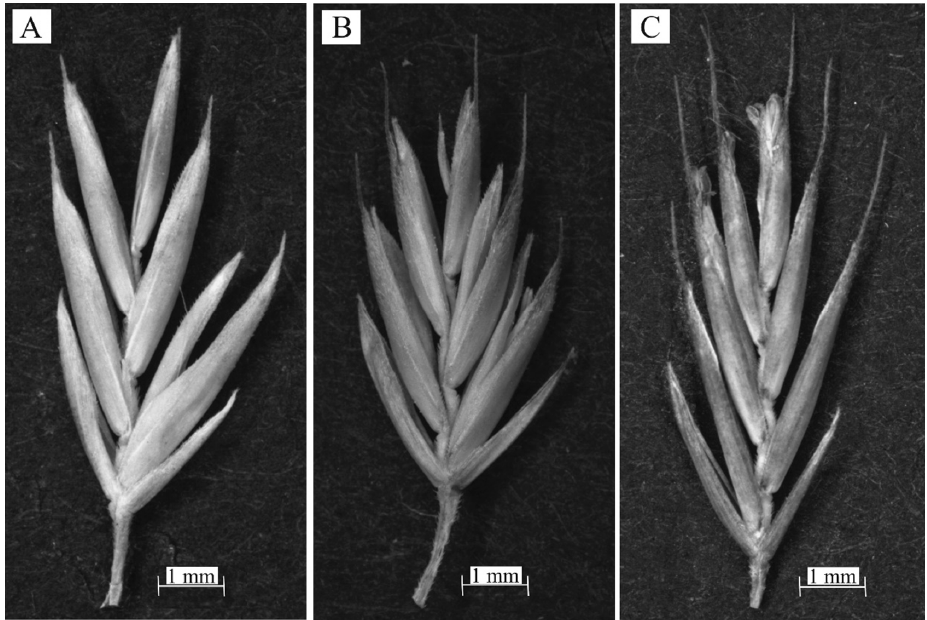
Figure 1. Typical spikelets of Festuca vaginata W. K. ( A ), Festuca pseudovaginata Penksza ( B ) and Festuca tomanii Korneck & T.Gregor ( C ).